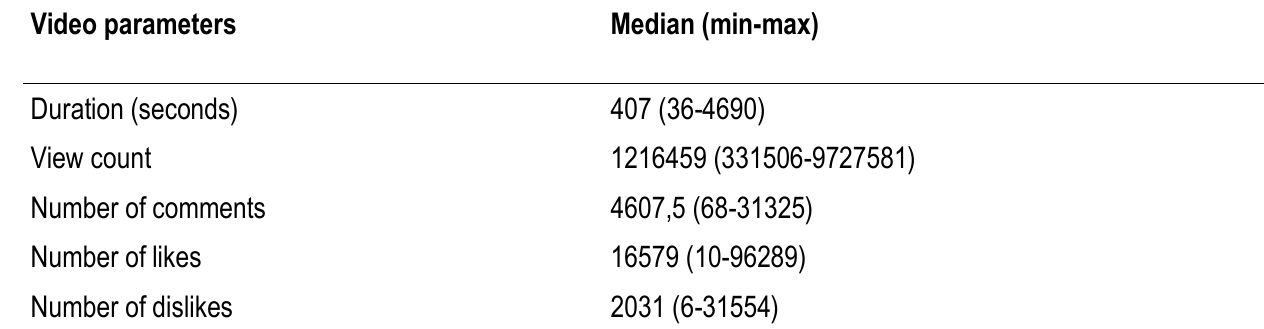
Table 1. Parameters of the videos